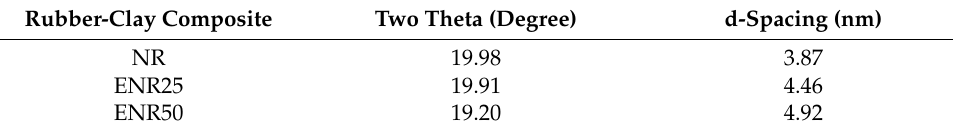
Figure 9. XRD patterns of NR-Clay, ENR25-Clay and ENR50-Clay composites at the mixing tempera- ture of 80 ◦ C by using dispersed bentonite clay in Et-OH. Table 5. Mechanical properties of NR-Clay, ENR25-Clay and ENR50-Clay composites. Table 4. Two theta and d-spacing of Rubber-Clay composite obtained from XRD analysis.